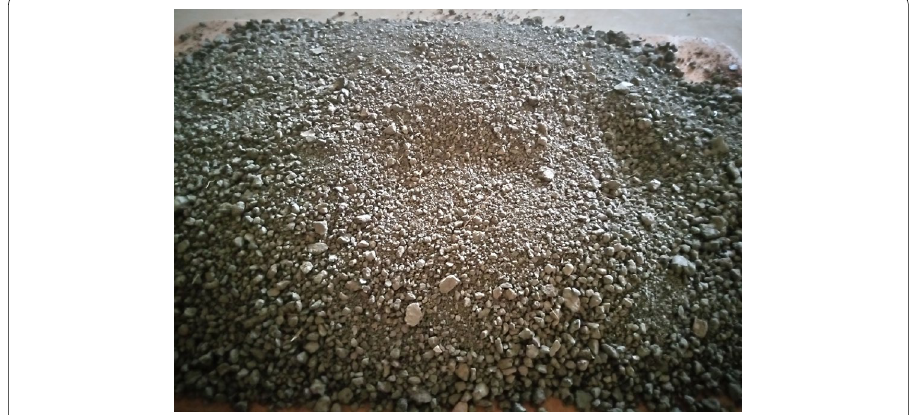
Fig. 1 Sample of the dried natural expansive